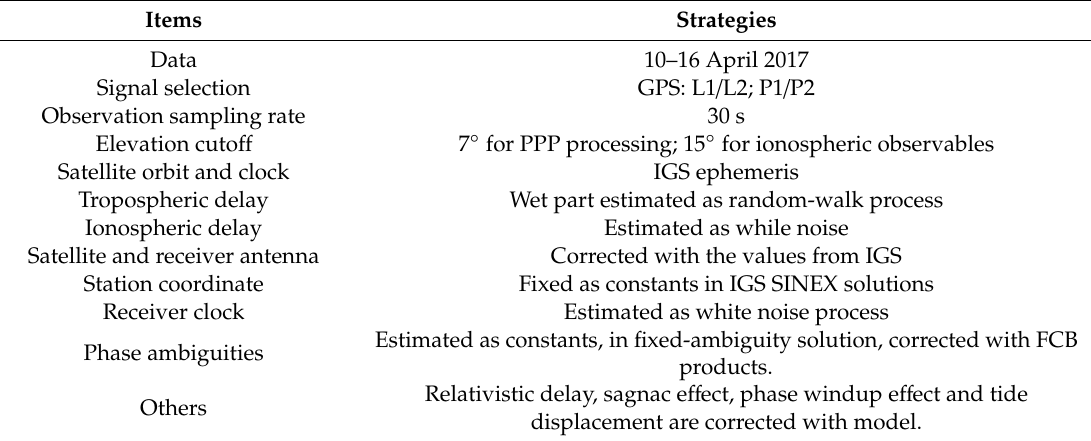
Table 2. Data processing strategies for uncombined